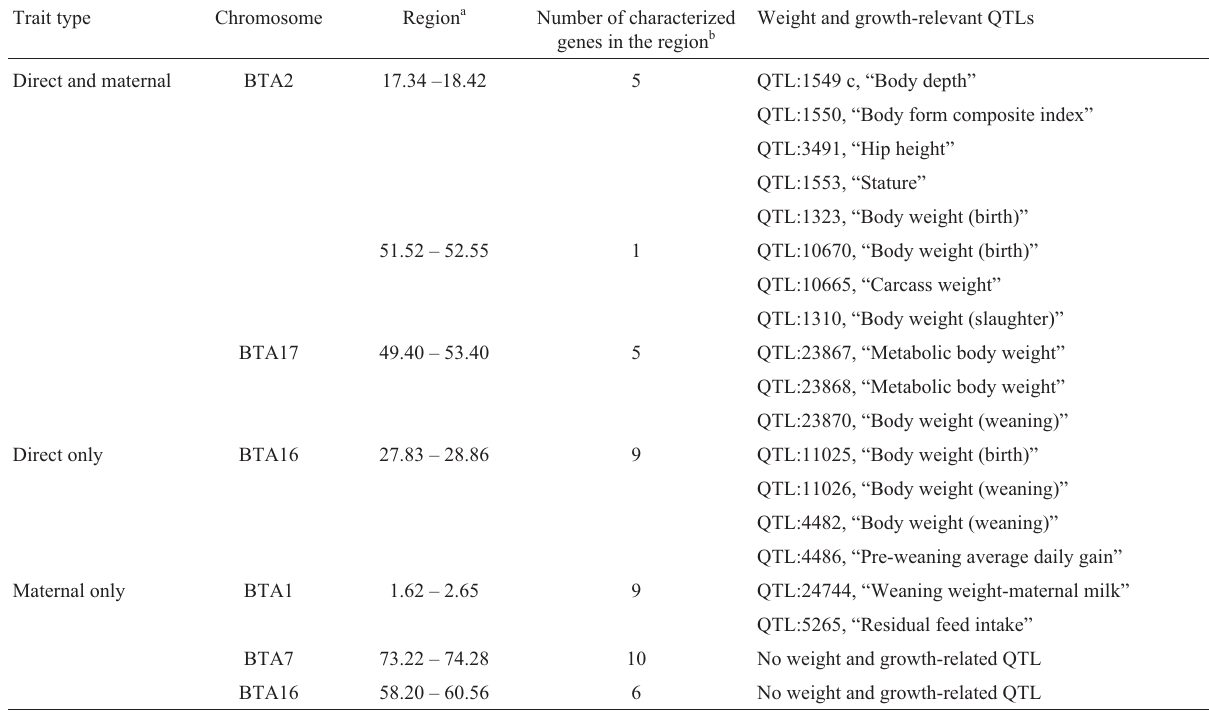
Table 2 - Most important regions of DNA related to birth weight in Zebu Brahman breed. Trait